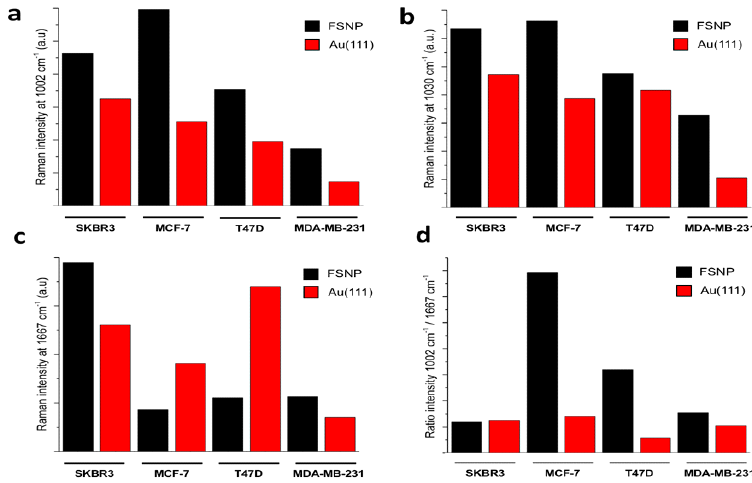
Figure 6. Raman intensities at ( a ) 1002 cm − 1 ; ( b ) 1030 cm − 1 ; ( c ) 1667 cm − 1 and ( d ) the ratio 1002 cm − 1 /1667 cm − 1 of the different breast cancer cell lines.